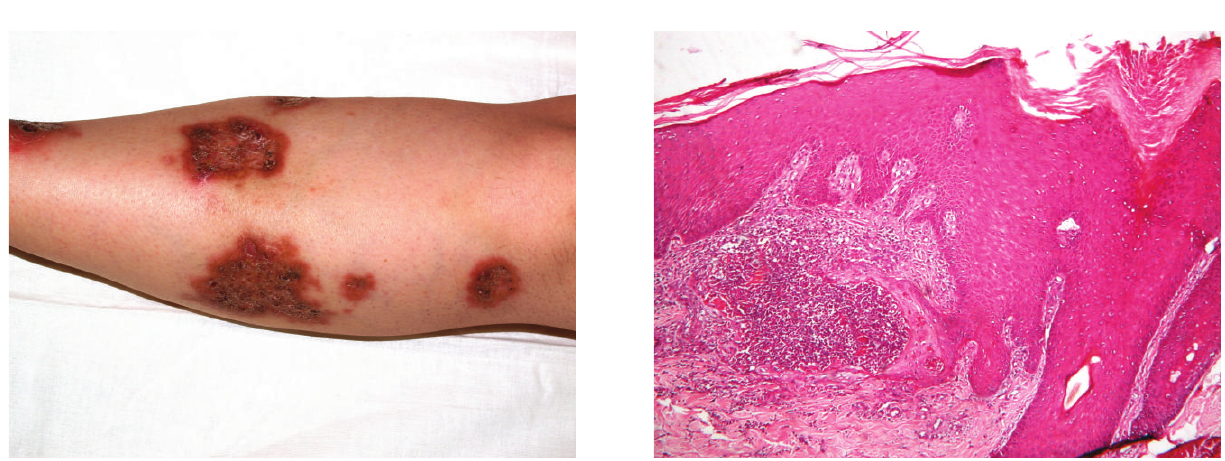
Figure 1: Infiltrated circinate plaques, erythematous border, and comedo-like papules in the center on the lower extremities of a 42- year-old diabetic patient.